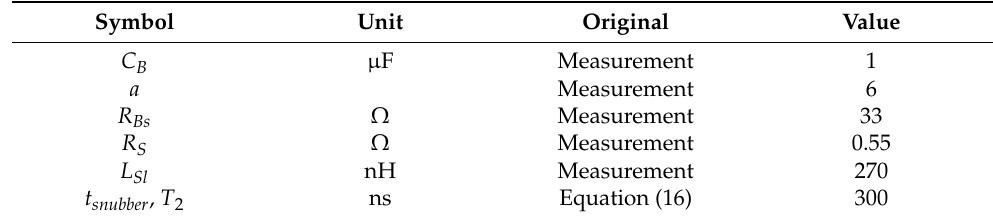
Table 2. Parameters used to estimate the snubber activated